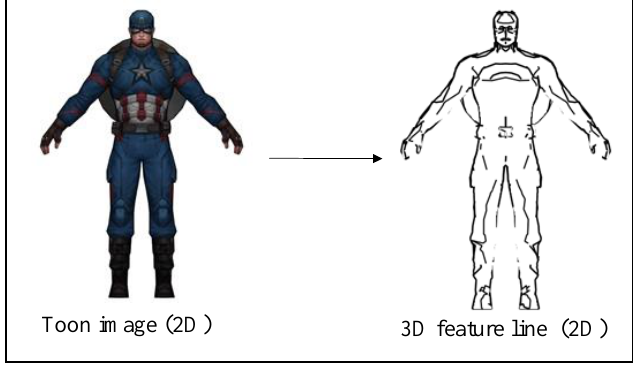
Figure 1. Feature lines extracted from the 2D images and 3D models.